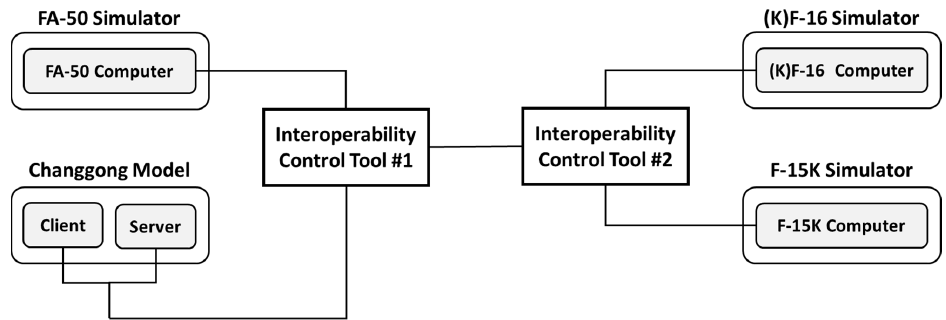
Figure 24. Overall hardware structure (adapted from [51]).